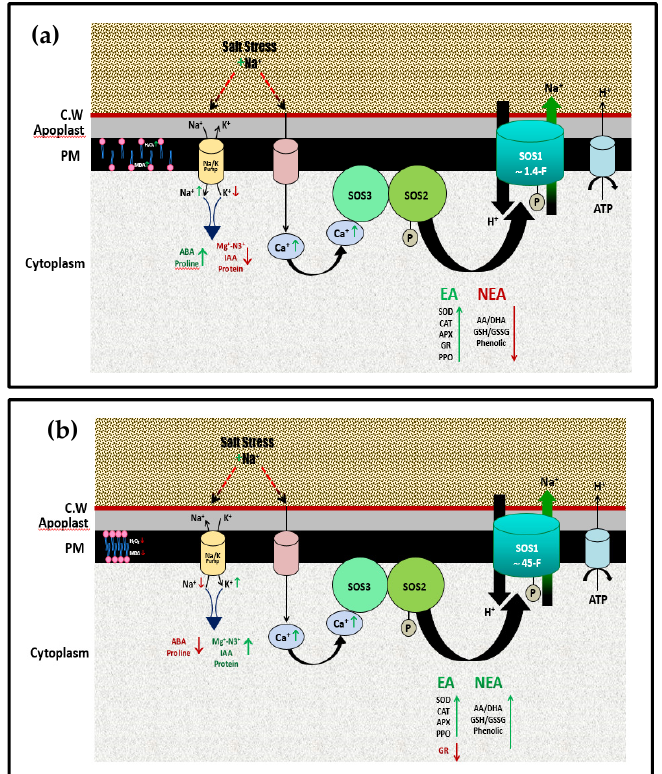
Figure 5. ( a ). Proposed regulation mechanism for the physiological role of SOS signaling pathway in response to 200 mM NaCl stress of Vicia faba plant leaves, adapted after [71]. CW: cell wall, PM: plasma membrane, EA: Enzymatic antioxidants; NEA: Non-Enzymatic antioxidants. ( b ). Proposed regulation mechanism for the physiological role of SOS signaling pathway in eliciting 200 mM NaCl stress of Vicia faba plant leaves previously supported with 10% VC, adapted after [71].